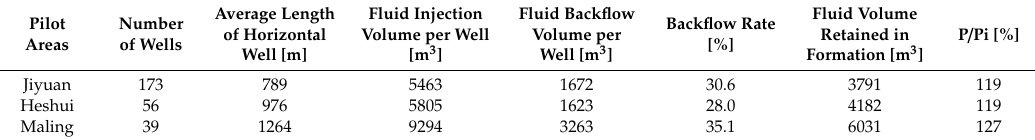
Table 5. Formation pressures during volume fracturing treatments in Chang 7.